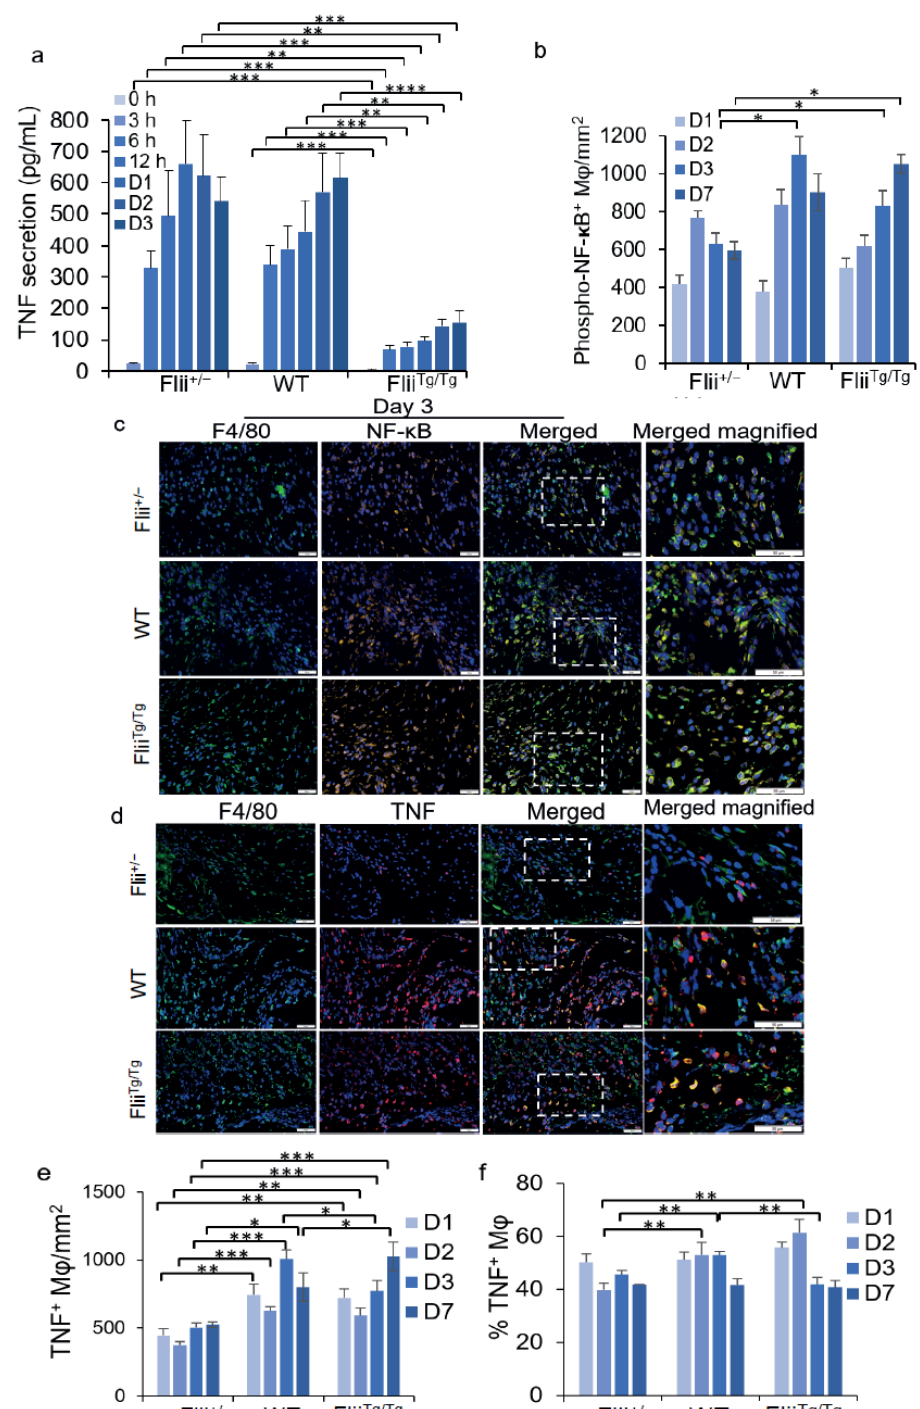
Figure 3. TNF secretion from macrophages and expression in wound macrophages from three Flii genotypes (Flii +/ − , WT, and Flii Tg/Tg ): ( a ) TNF secretion from LPS-activated macrophages; ( b ) representative images of murine wounds immunostained for TNF + and F4/80 + at day 3; Bar charts showing ( c ) the number and ( d ) the percentage of TNF + F4/80 + macrophages in the wounds of the 3 Flii genotypes; ( e ) Representative images of murine wounds immunostained for phosphorylated NF- κ B + and F4/80 + at day 3; ( f ) Bar chart showing the number of phosphorylated NF- κ B + F4/80 + macrophages in the wounds of the 3 Flii genotypes ( n = 6). Scale bars = 50 µ m. Results are expressed as mean ± SEM. * p < 0.05, ** p < 0.01, *** p < 0.001, and **** p <